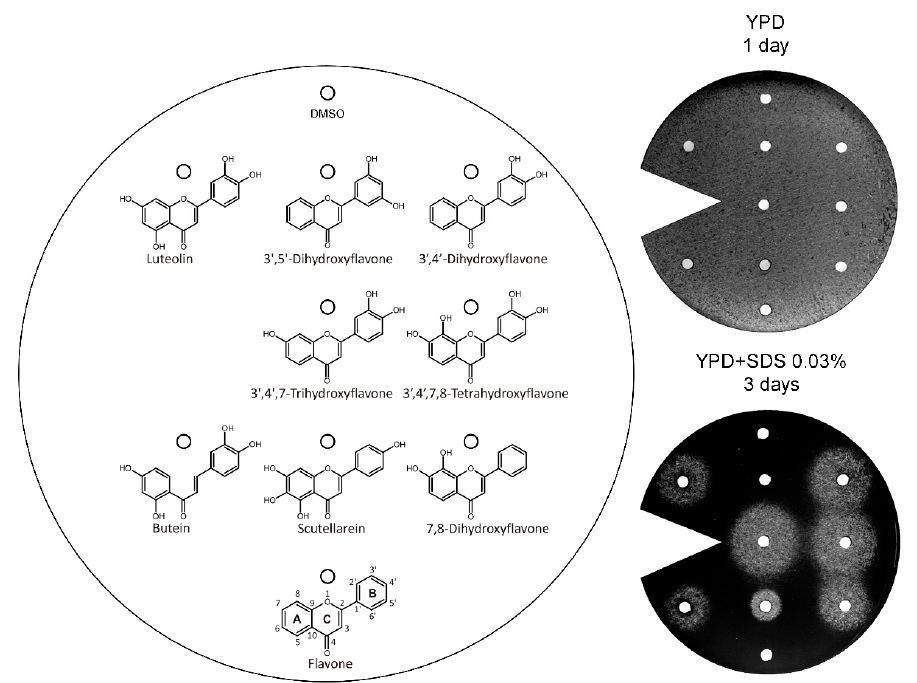
Figure 3. The vps13 ∆ growth-restoring activities of various flavonoids. The vps13 ∆ strain was plated on YPD + SDS 0.03% and YPD for control. The structure of compounds, belonging to different structural subclasses, are shown. Luteolin was used as positive control, and DMSO as negative control. Compounds were applied at 30 µ g per spot, according to the diagram. Plates were incubated for 1 or 3